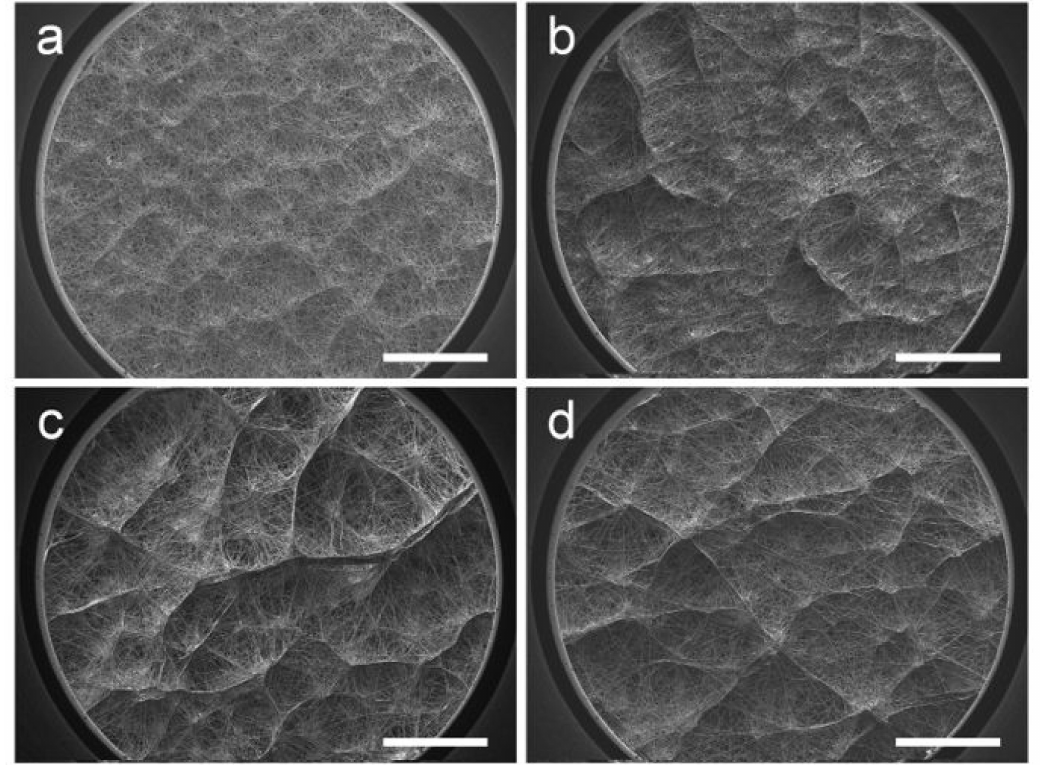
Figure 4. SEM images of e-spun films at different humidity levels—( a ) 40%, ( b ) 50%, ( c ) 60% and ( d ) 70%—at a receiving temperature of − 10 ◦ C. Scale bars are 1